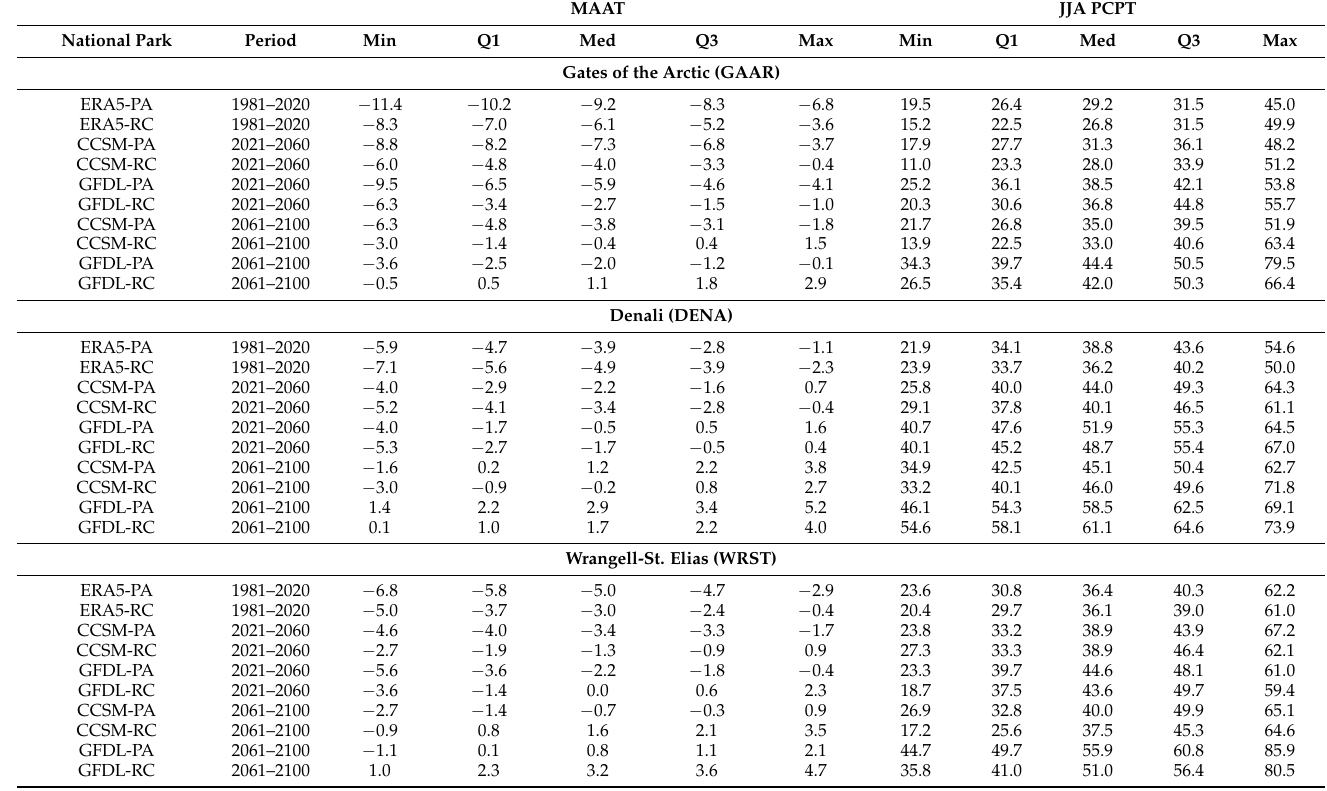
Table 3. ERA5 historical (1981–2020) and bias-corrected CCSM and GFDL mid-century (2021–2060) and late-century (2061–2100) projected boxplot values of mean annual air temperature (MAAT; ◦ C) and summer precipitation (JJA PCPT; cm) for the three national parks (i.e., GAAR, DENA, and WRST). These values include the: minimum (Min), lower quartile (Q1), median (Med), upper quartile (Q3) and maximum (Max). Each park’s grid-point average (PA) and road corridor average (RC) are given. MAAT JJA